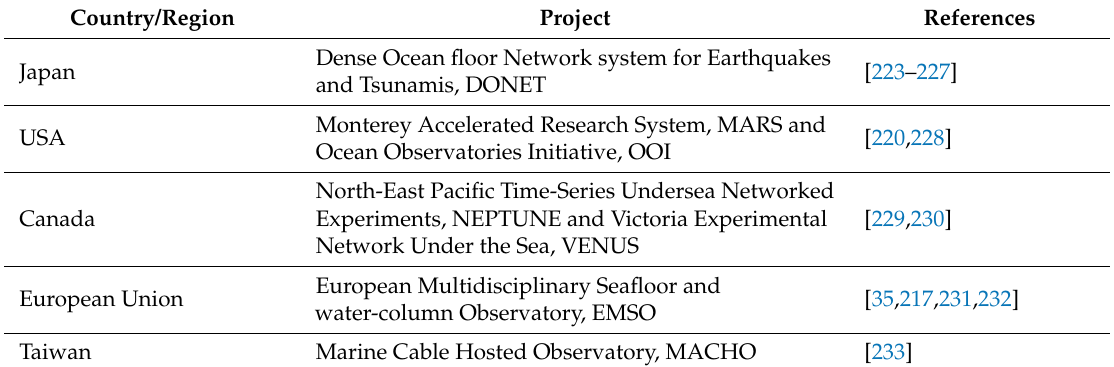
Table 2. Main seafloor observatories initiatives registered in scientific